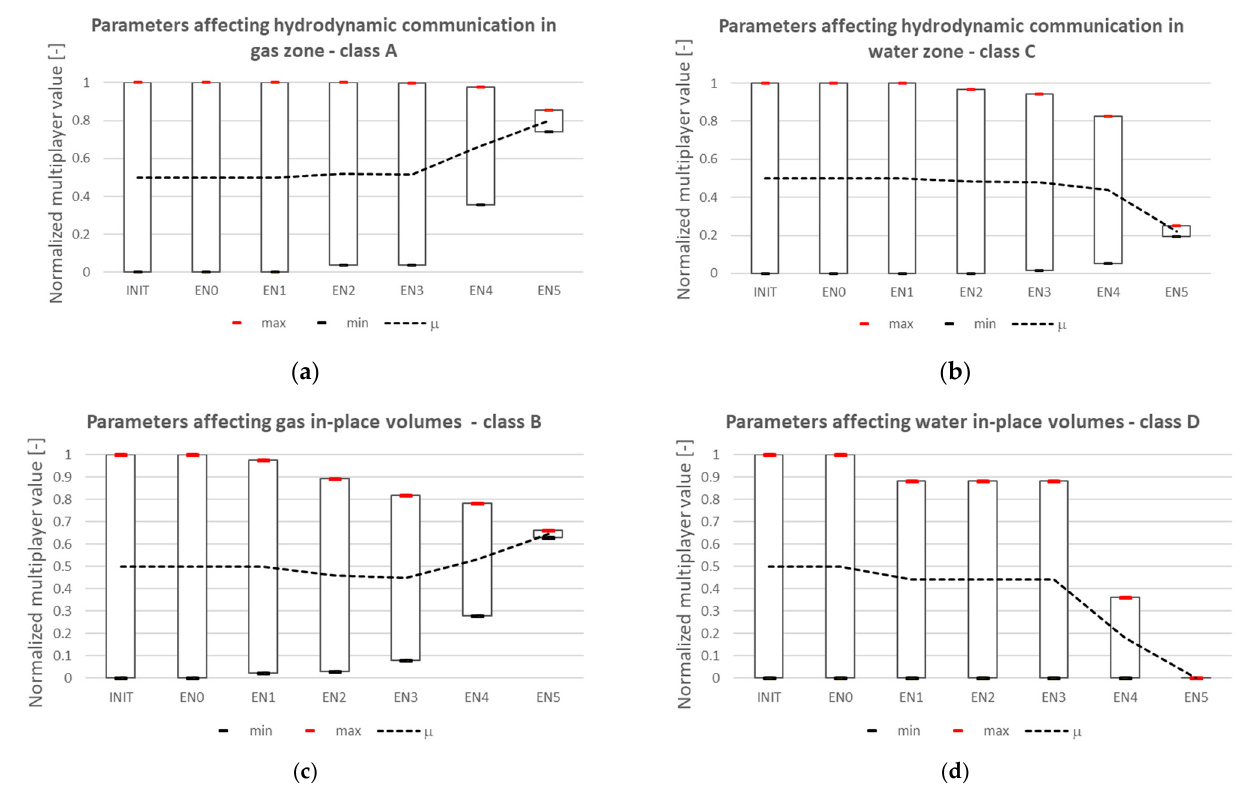
Figure 5. The change of normalized parameters affecting pressure development in the reservoir, history-matching using one year of production data—geological scenario mix. ( a ) class A; ( b ) class C; ( c ) class B; ( d ) class D.